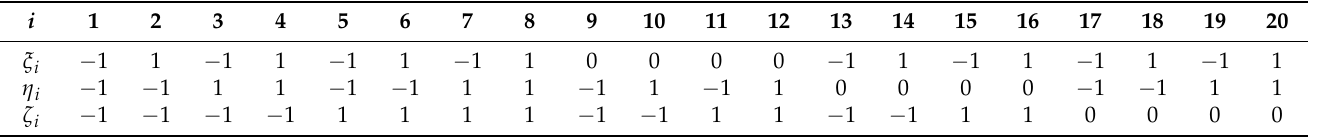
Table 1. Node coordinates in the computational